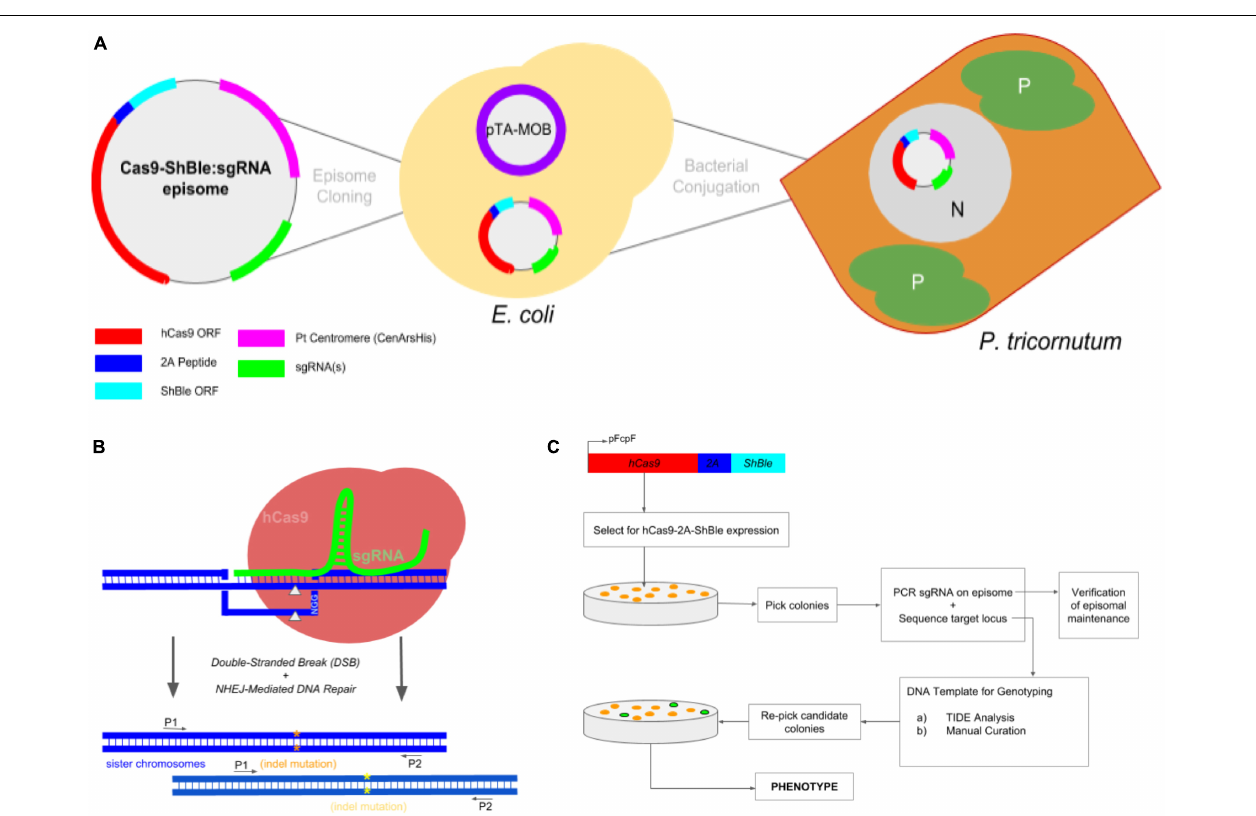
FIGURE 1 | Experimental workflow to produce Phaeodactylum mutants via conjugation-based delivery of a CRISPR-Cas9 episome. (A) A cartoon schematic of Cas9-Sh ble:sgRNA episome cloning to E. coli cells harboring the pTA-MOB plasmid and followed by bacterial-conjugation transformation of the episome to Phaeodactylum . Phaeodactylum cells maintain and replicate the Cas9-Sh ble:sgRNA episome as their native chromosomes in the nucleus (N). The diatom plastids (P) and cytoplasm (C) are labeled. Here, Cas9 is transcriptionally fused to sh ble and can therefore be selected for after transformation with the antibiotic phleomycin. (B) Episomal expression of Cas9 and sgRNA(s) and target mutagenesis of a diploid organism. The sgRNA(s) guides Cas9 to genomic target(s), and then Cas9 induces a double-stranded break (gray arrows). Phaeodactylum , being a diploid eukaryote, will contain two distinct NHEJ-mediated mutations (orange and yellow asterisks) between the sister chromosomes. (C) Genotyping and cell line picking workflow after colony selection for Cas9-Sh ble. A “double picking” strategy was used by which cell lines were picked and target locus sequenced using two primers. After genotyping, the colony can be re-picked for further cell line